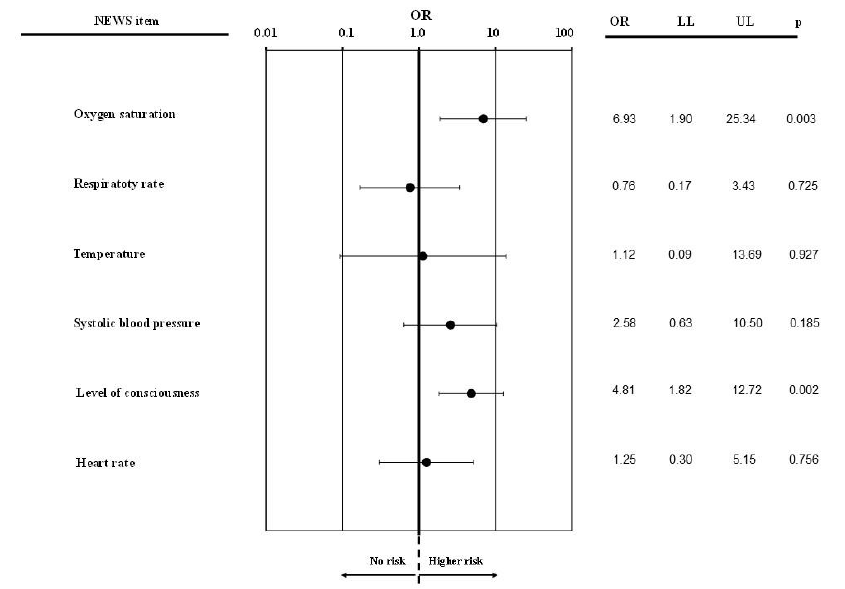
Figure 5. NEWS value with a 3-single parameter and predictors of hospitalization.